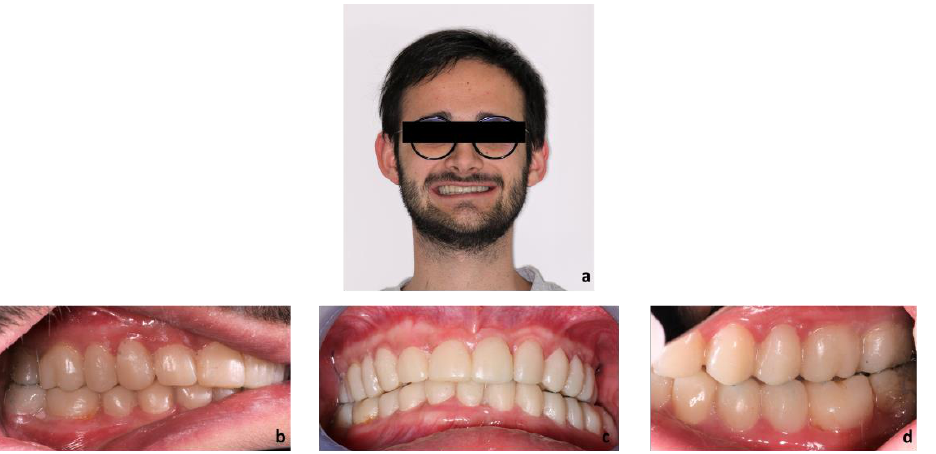
Figure 5. Exo ( a ) and endobuccal views with wax-up: ( b ) right side occlusion, ( c ) front bite, ( d ) left side occlusion.